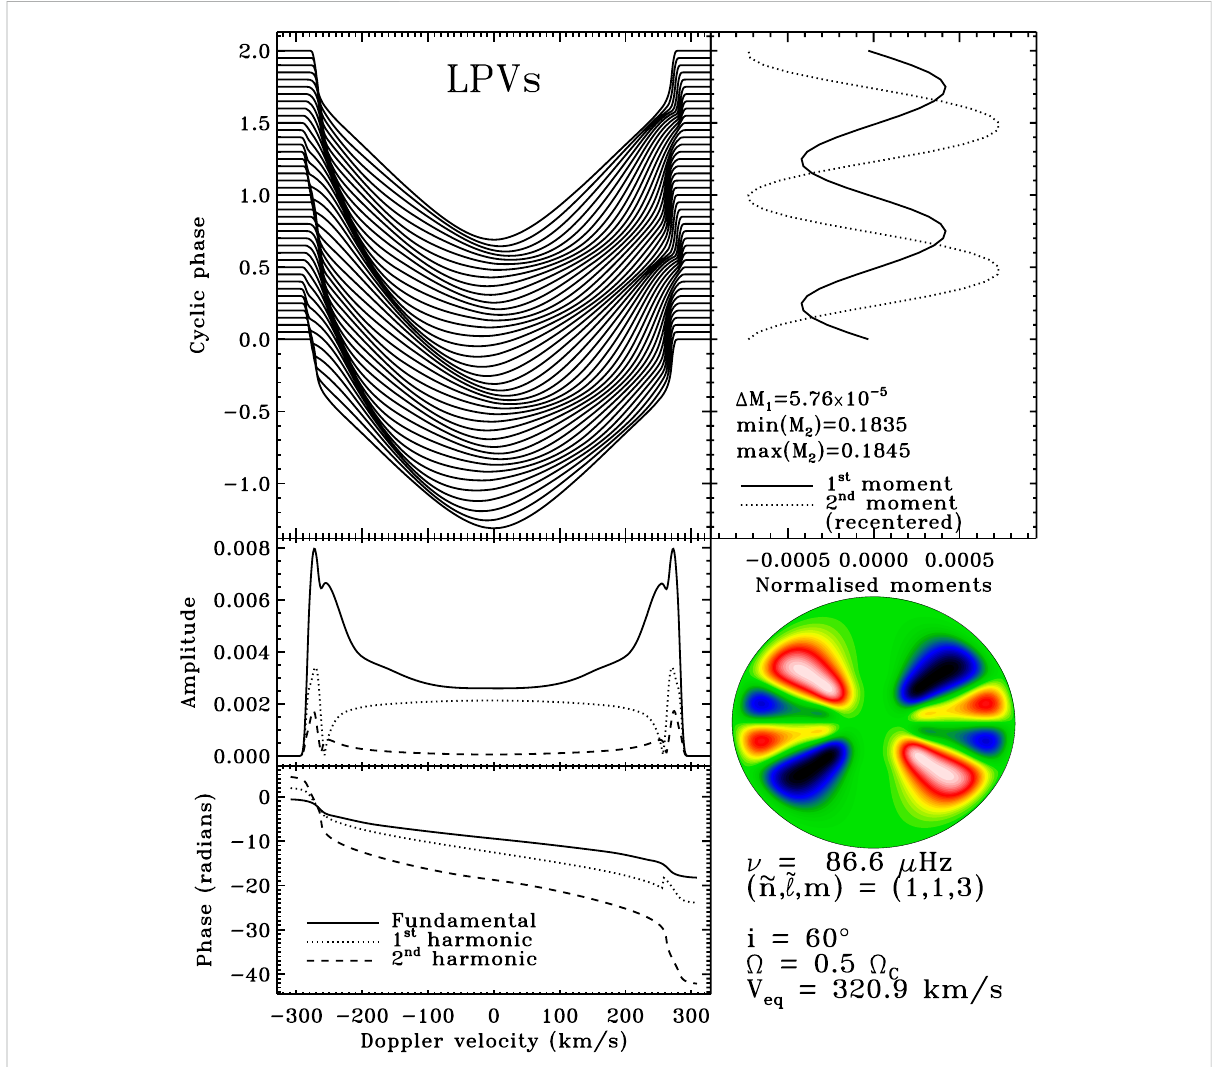
Line-pro fi le variations in a 9M ⊙ ESTER model at 50% of its breakup velocity. Left, top to bottom: stacked line pro fi les, amplitudes and phases of the fi rst three harmonics. Right, top to bottom: fi rst and second moments of the LPVs, meridional cut of the oscillation mode, and model properties. Figure taken from Reese et al.